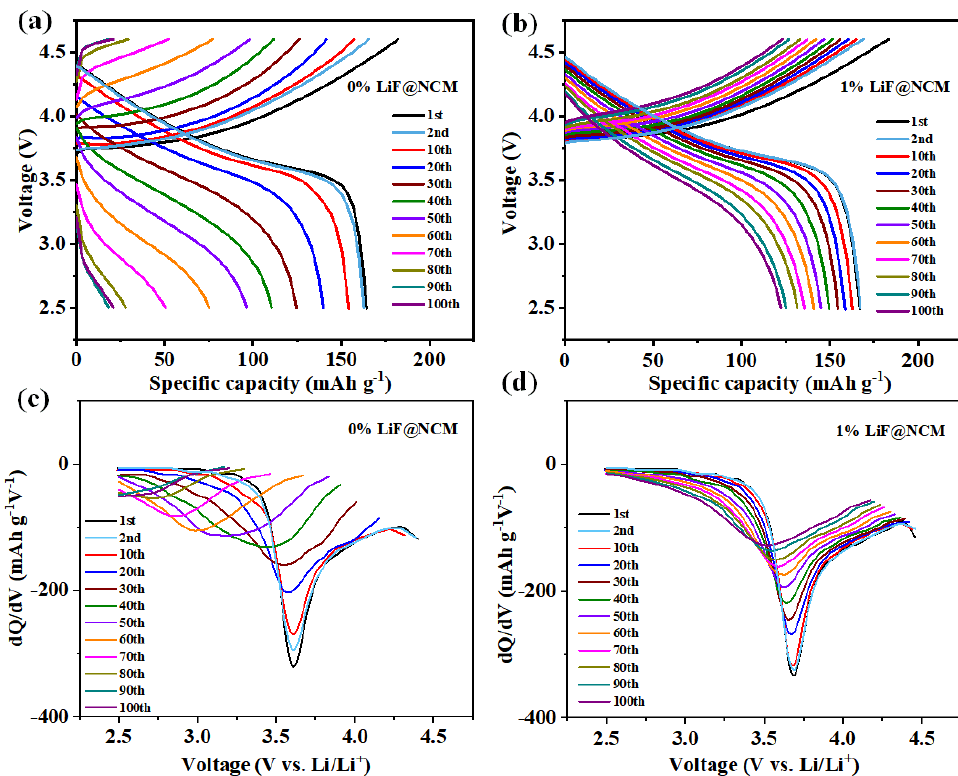
Figure 8. The electrochemical properties of ( a ) 0%LiF@NCM, ( b ) 1%LiF@NCM; dQ/dV curves of ( c ) 0%LiF@NCM, ( d ) 1%LiF@NCM.